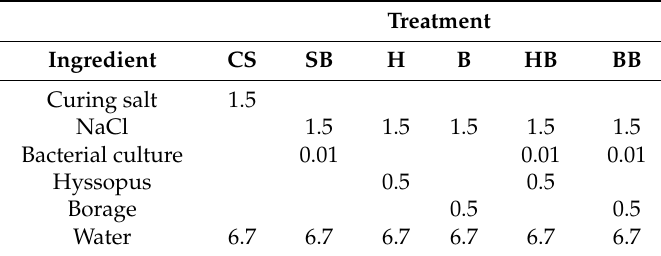
Table 1. Composition of ingredients in production variants (% of meat